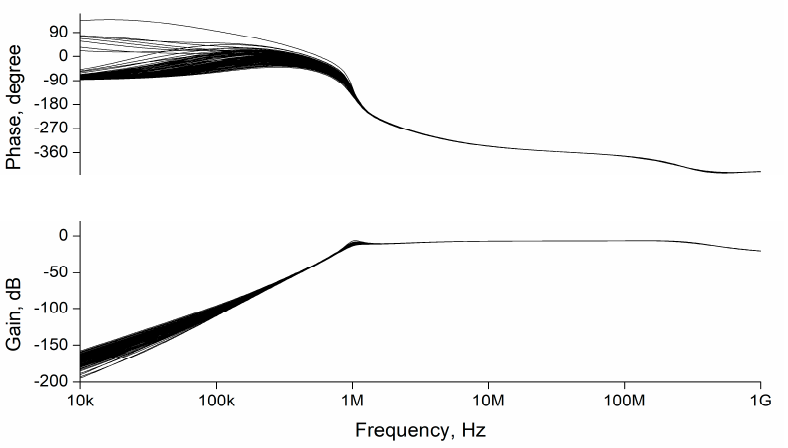
Figure 13. Monte Carlo simulations of the HP ladder filter with changes of all the passive elements.